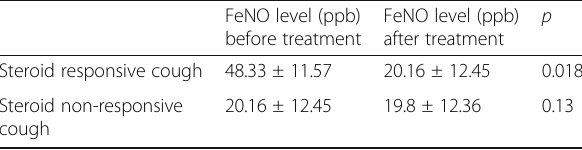
Table 3 FeNO before and after treatment in the studied patients with steroid responsive and non-responsive cough FeNO level (ppb) FeNO level (ppb) before treatment after